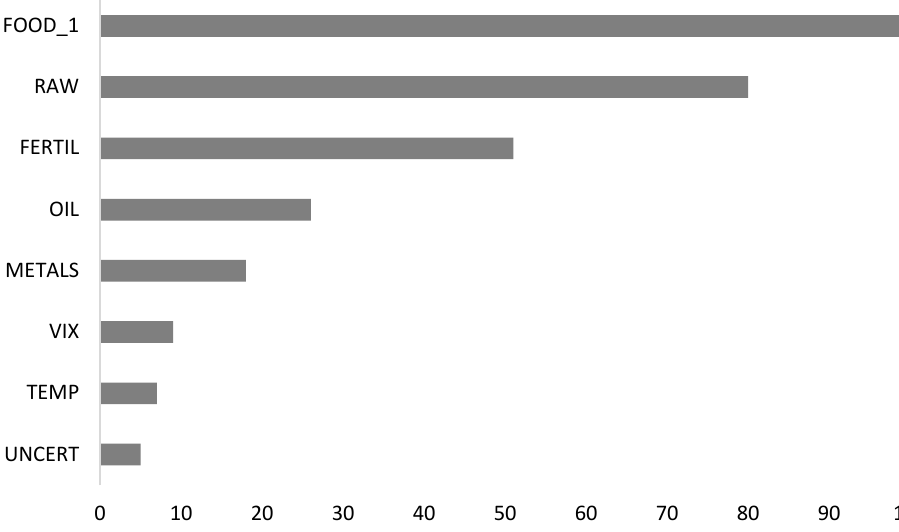
Figure 3. Variable importance analysis.